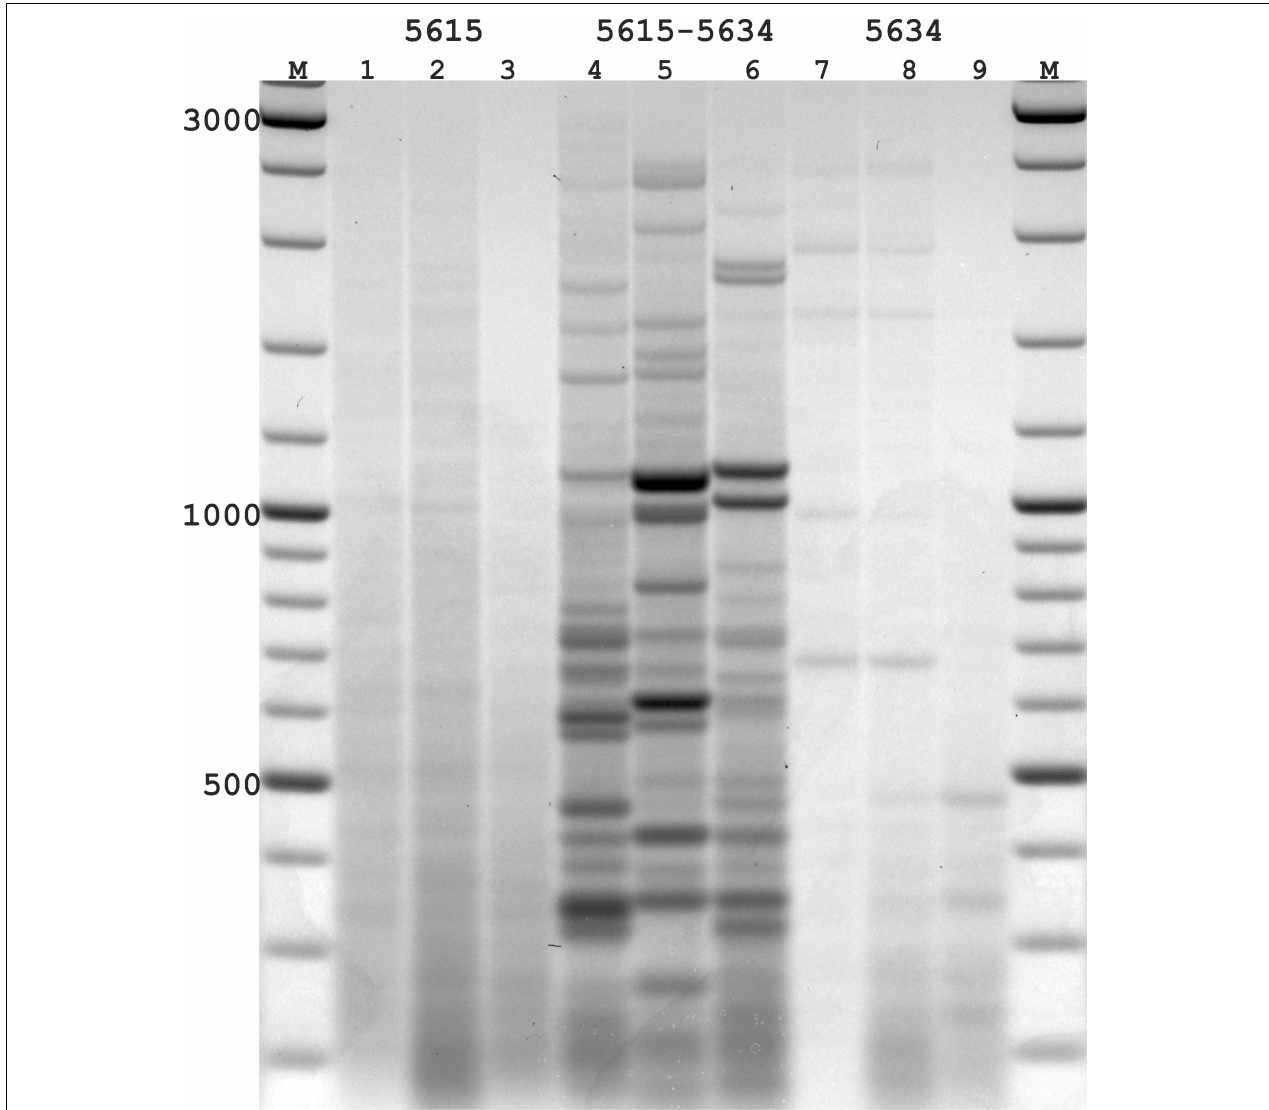
FIGURE 3 | PST-PCR v.2 used for transposon display (TD) for Ac elements in the maize genome. Lanes represent PST-PCR v.2 amplification results for maize lines and a hybrid: 1, A632 (PI587140); 2, hybrid A619 × A632 (Ames23710); 3, A619 (PI587139). Lane M – size markers. Only one primer (PST primer 5615) was present during the first-round PCR for samples in lanes 1–3. Both primers (SSP 5634 and PST primer 5615) were present during the first-round PCR for samples in lanes 4–6. Only one primer (SSP 5634) was present during the first-round PCR for samples in lanes 7–9. A specific and efficient amplification is visible only when both SSP and a PST primer are present in the first